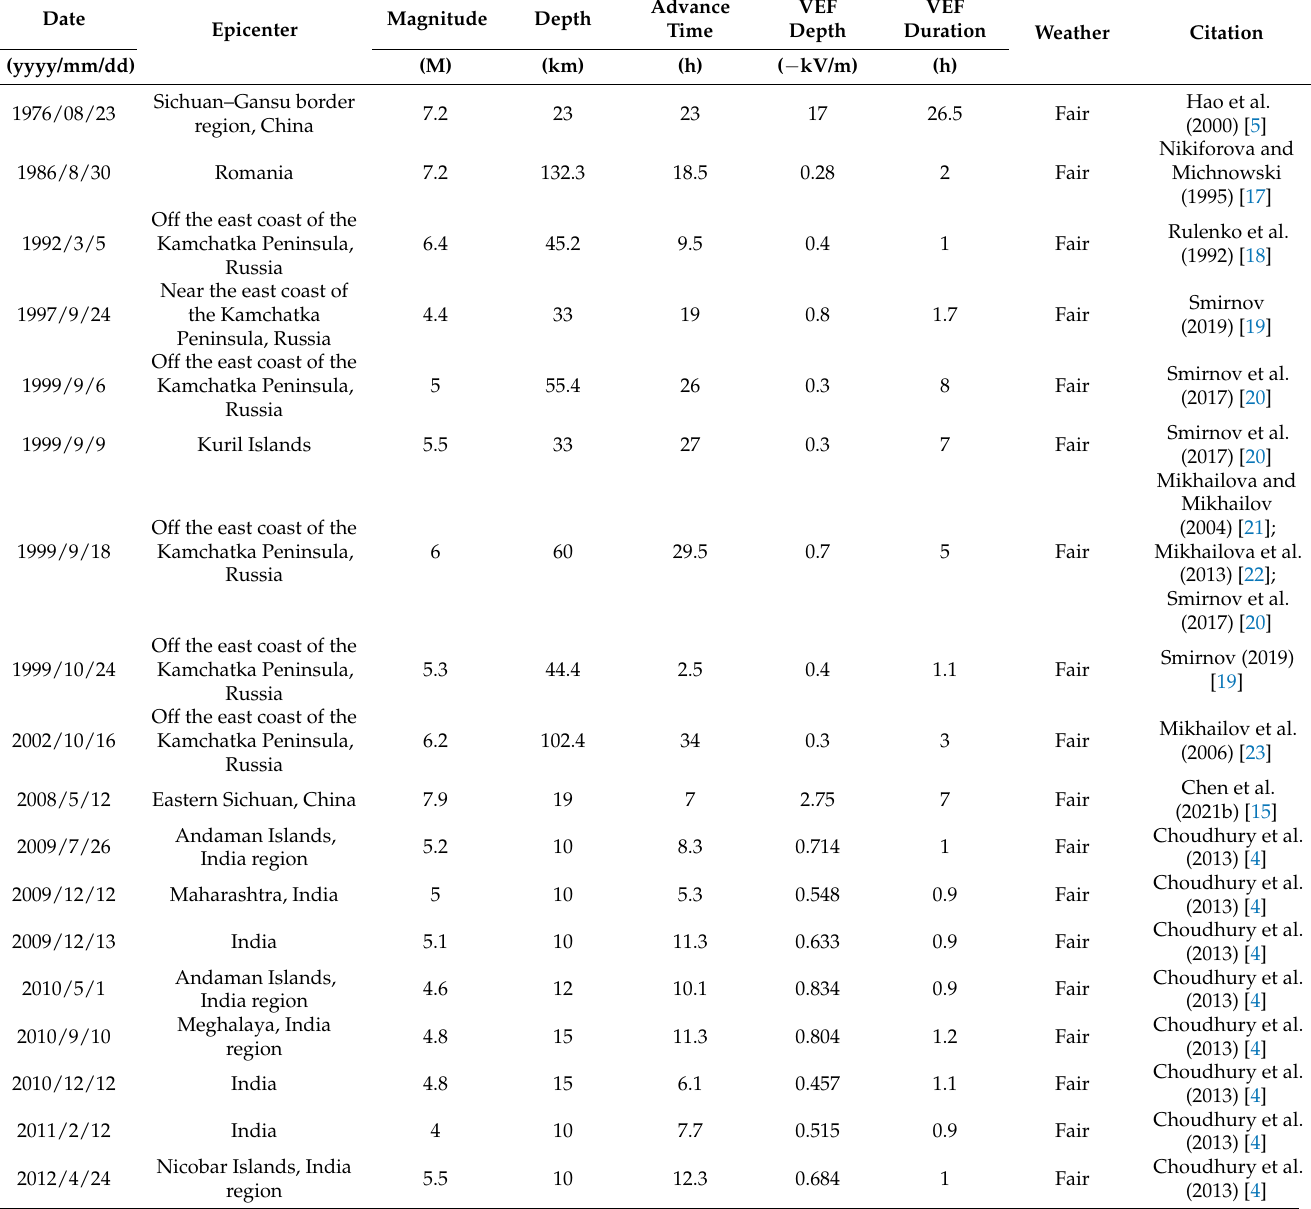
Table 1. Inland EQs reported in the